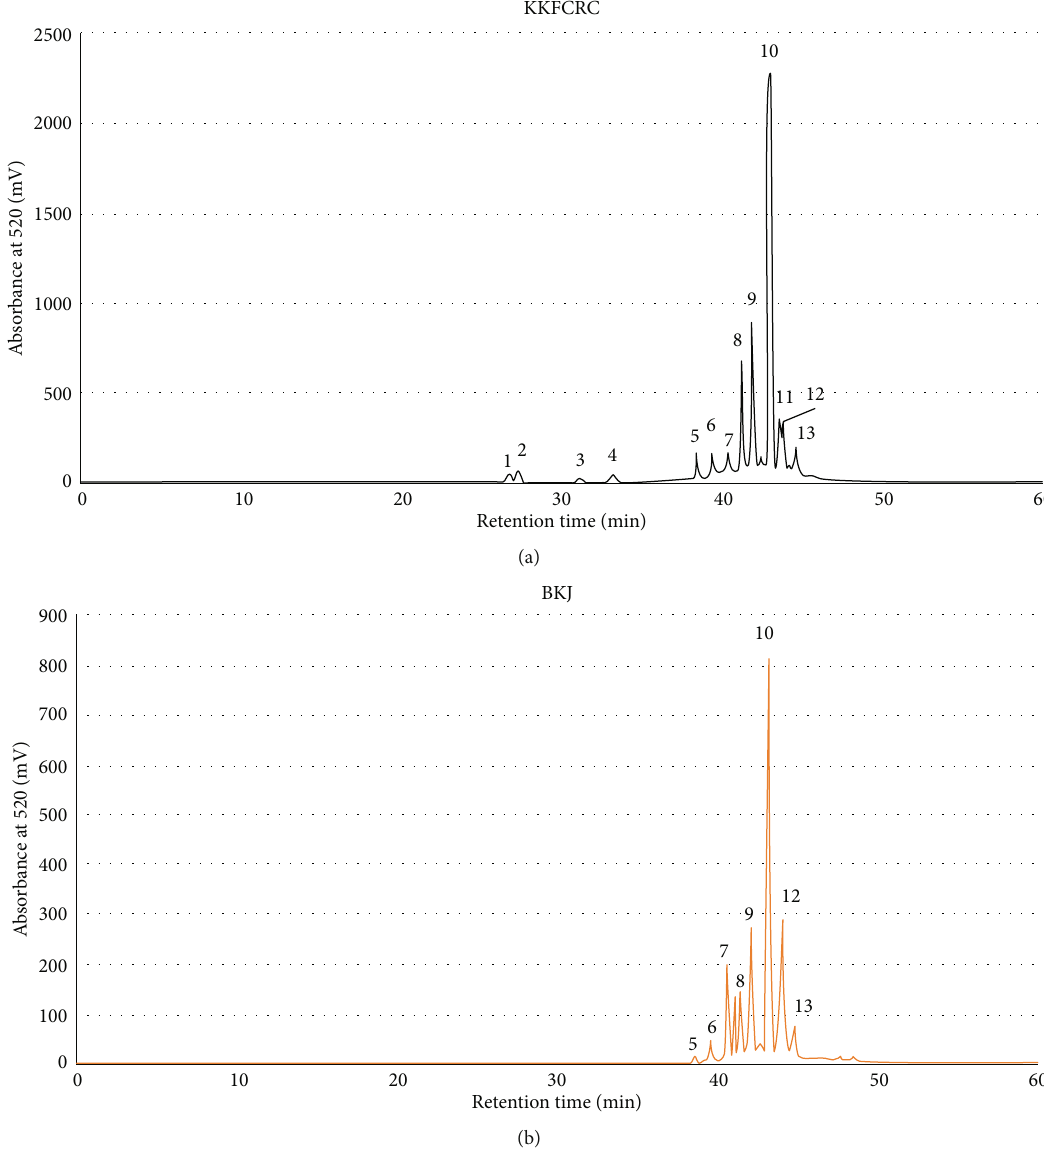
Figure 4: LC pro fi le of the EtOH extracts of the (a) KKFCRC and (b) BKJ tuber accessions at 520 nm. Peak numbers correspond to KKFCRC anthocyanins in Table